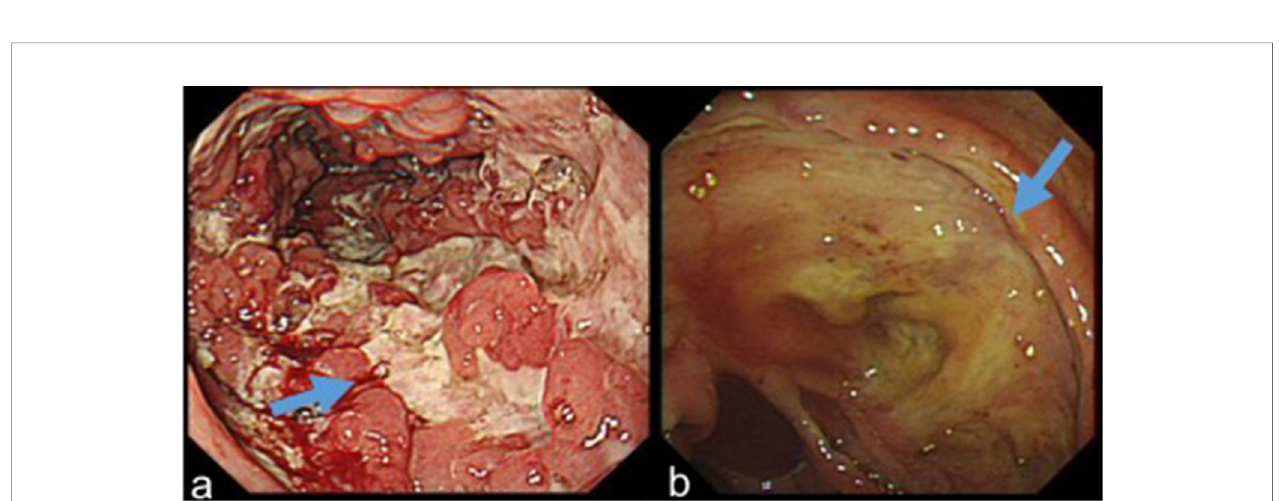
FIGURE 1 | (A) Longitudinal ulcers, in fl ammatory polyps and cobblestone sign in a patient with CD. (B) A large and deep ulcer in a patient with